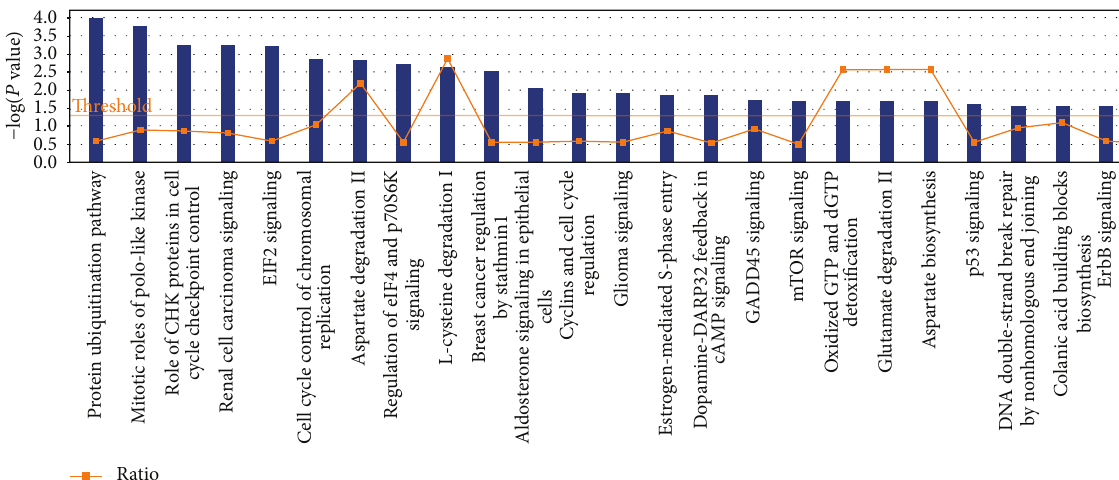
Figure 1: This graph shows the most statistically significant pathways involved in methylation variations of gene promoters between early and late passages of hBM-MSCs, obtained by Ingenuity Pathway Analysis (IPA). Blue bars indicate − log( 𝑃 value), while the orange squares indicate the ratio of input list genes that map to the considered pathway divided by the total number of genes involved in this specific pathway.